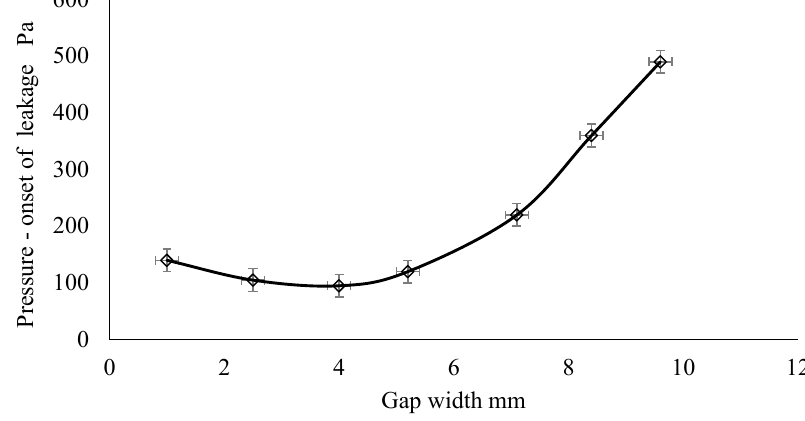
Figure 12. Dependence of onset leakage pressure on gap width for the window head joint and the runoff rate set at 2 g/s·m.